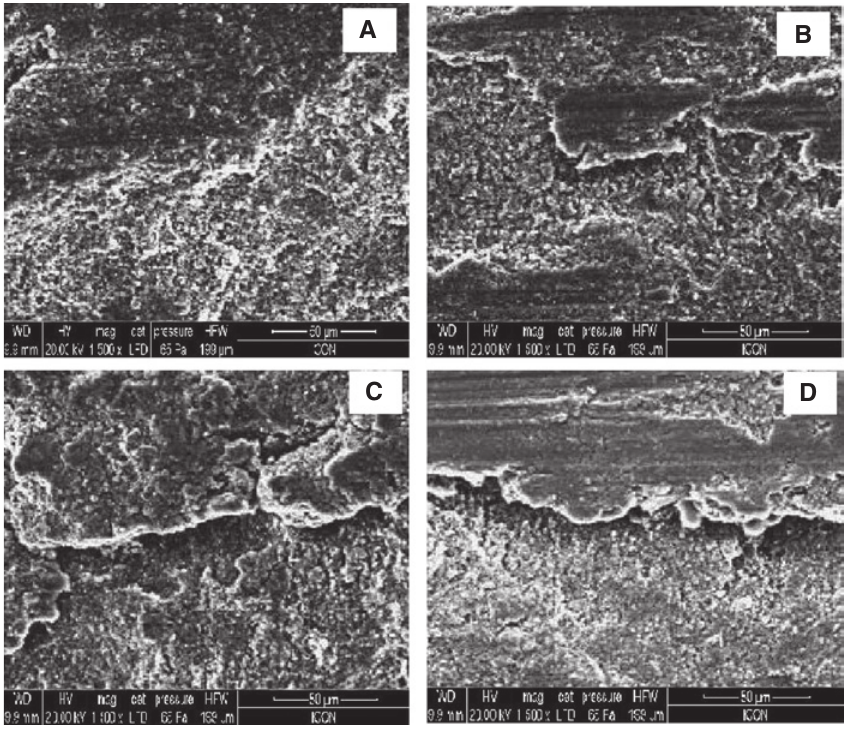
Figure 6 SEM micrographs of the worn surfaces of (A) 0% CNT, (B) 0.33 wt% CNT, (C) 0.66 wt% CNT, and (D) 1 wt% CNT